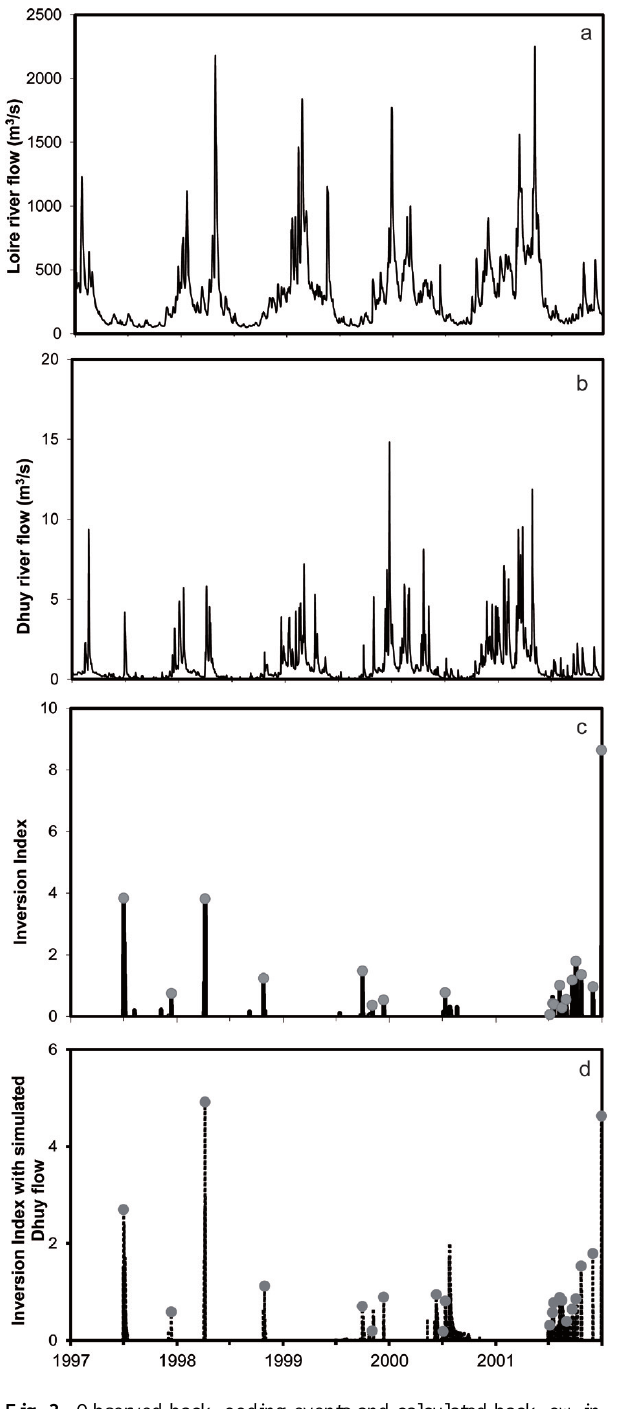
Fig. 3. Observed backflooding events and calculated backflow in- dices for 1997 to 2001. From the top down: Loire river flow (a) , Dhuy river flow (b) , backflow index calculated with the actual Dhuy river flows and the backflooding observations (grey circles) (c) , backflow index calculated with the Gardenia-calculated Dhuy river flows and the backflooding observations (grey circles) (d)